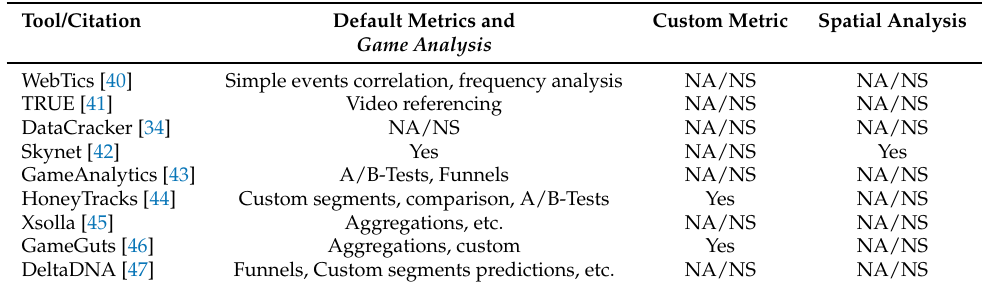
Table 5. Comparison of data processing and analysis related features among academic and commercial tools for game analytics. NA/NS = Not Applicable, Not Specified or